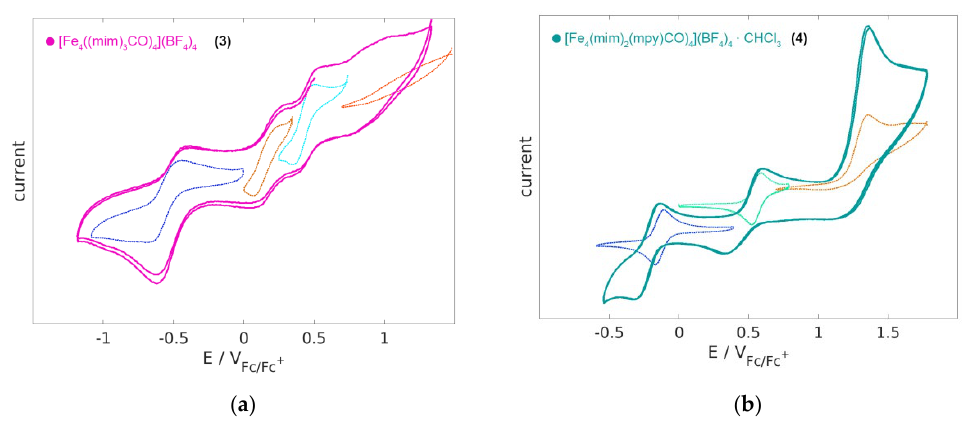
Figure 10. Cyclic voltammograms of 3 ( a ) and 4 ( b ).